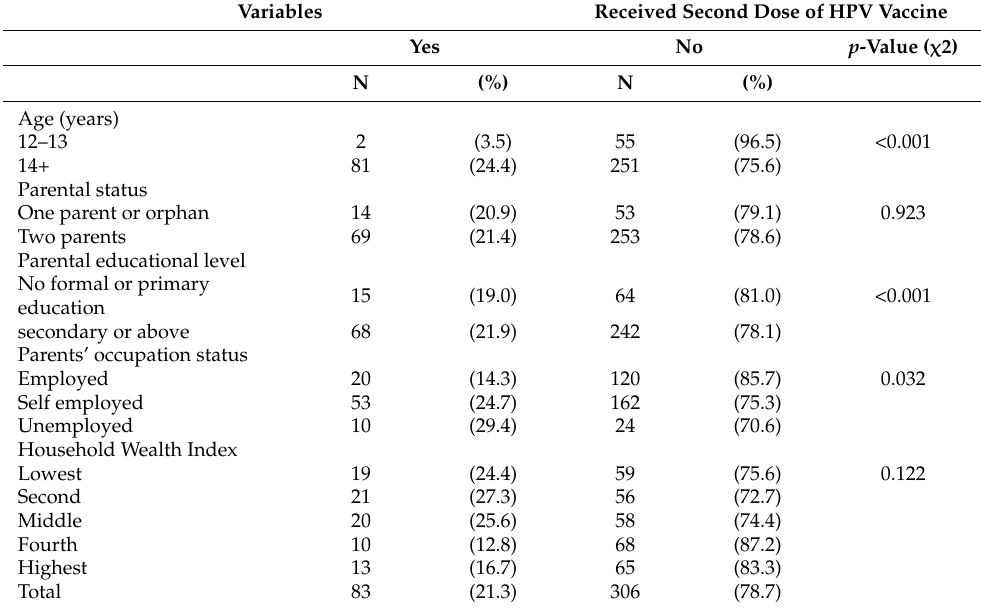
Table 1. Characteristics of HPV-2 uptake.